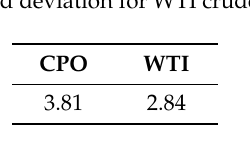
Table 2. Standard deviation for WTI crude oil and CPO.